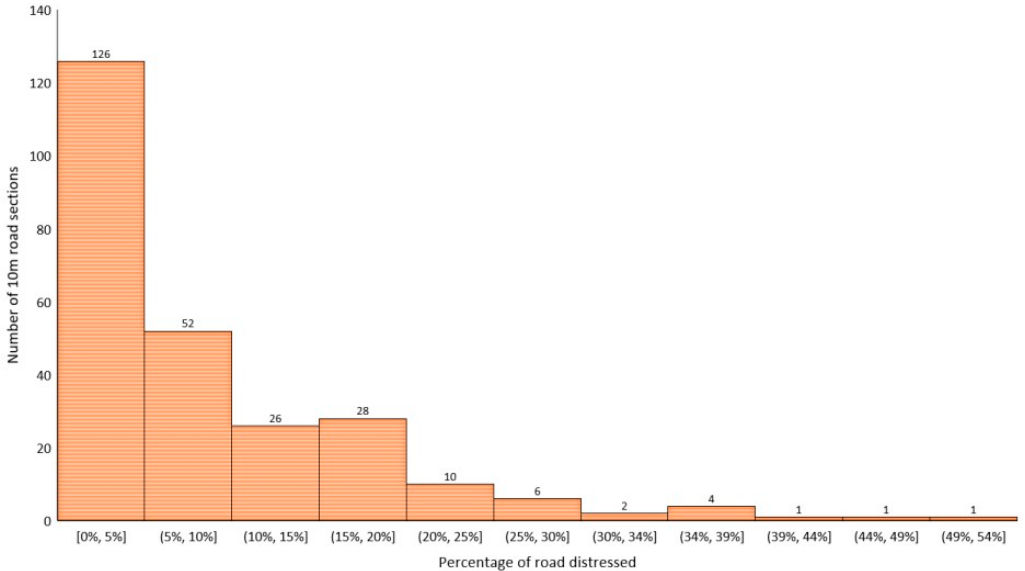
Figure 19. Histogram displaying of sections of the road and the respective percentages distressed.